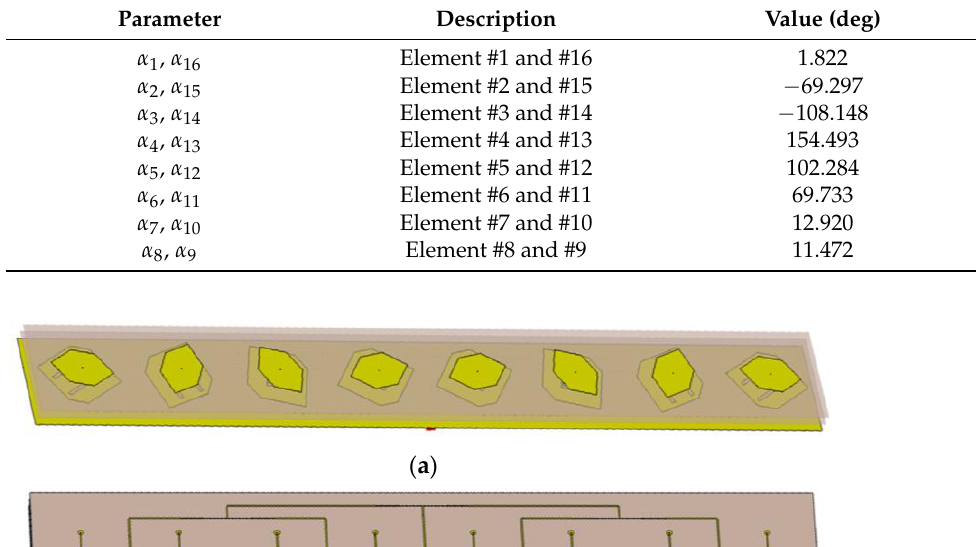
Figure 8. Phase-only synthesis with 16 radiating elements and 8 even Chebyshev basis functions. Element spacing is 0.65 λ 0 . ( a ) Radiation pattern; ( b ) Basis function weights; ( c ) Excitation phase; ( d ) Excitation amplitude.